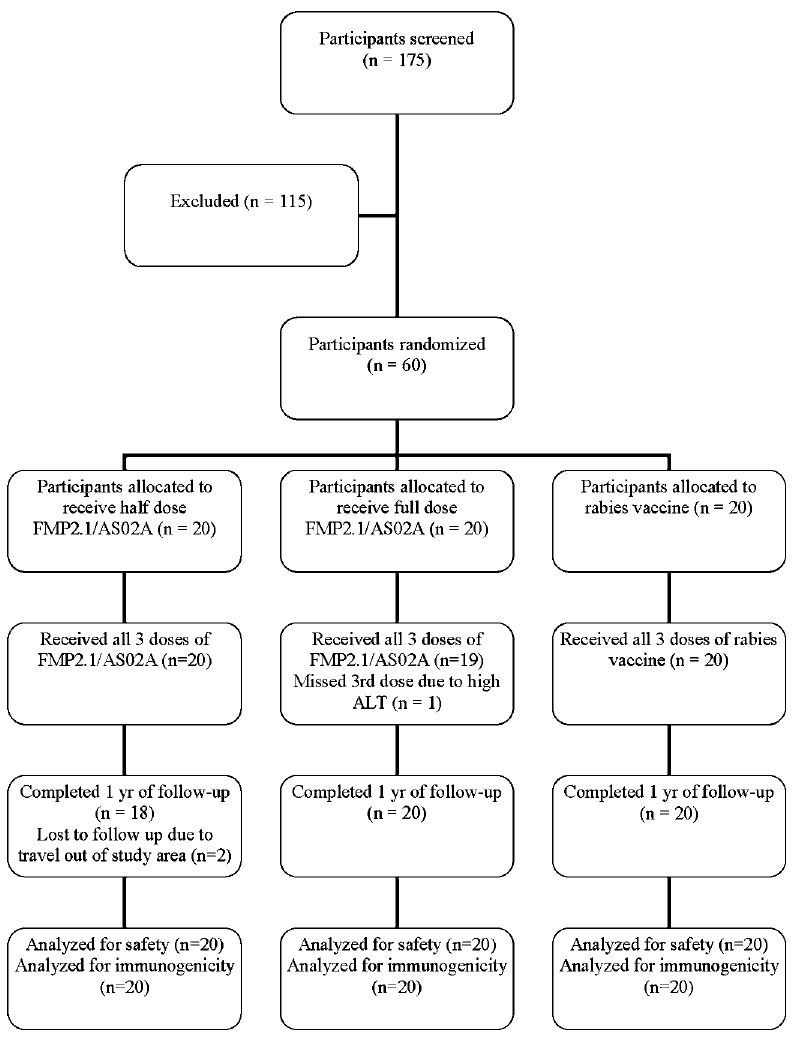
Figure 1. Trial Profile.